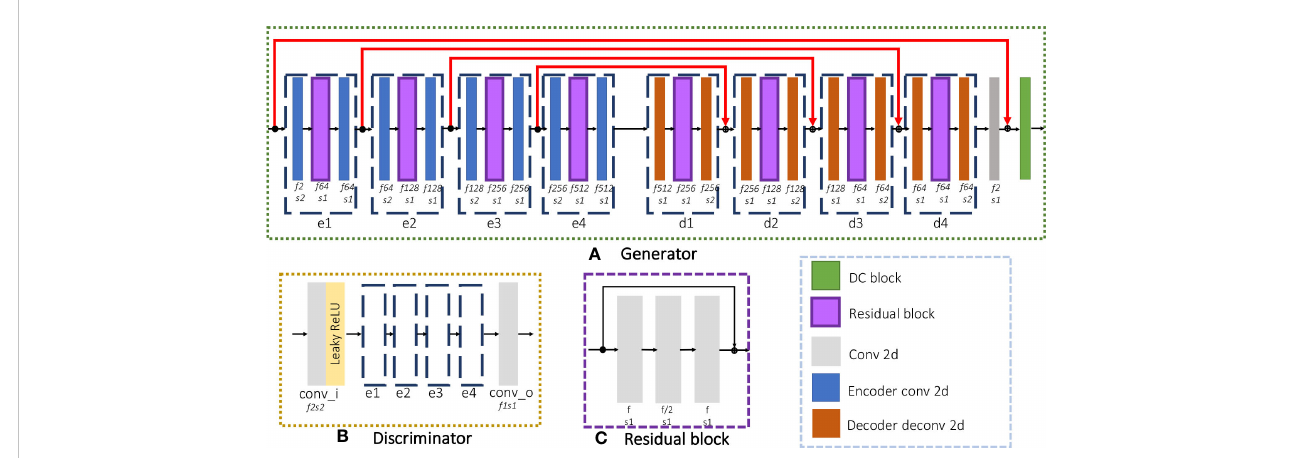
FIGURE 2 The detailed architecture of each GAN consisted of a (A) Generator and a (B) Discriminator and (C) the residual block used in the